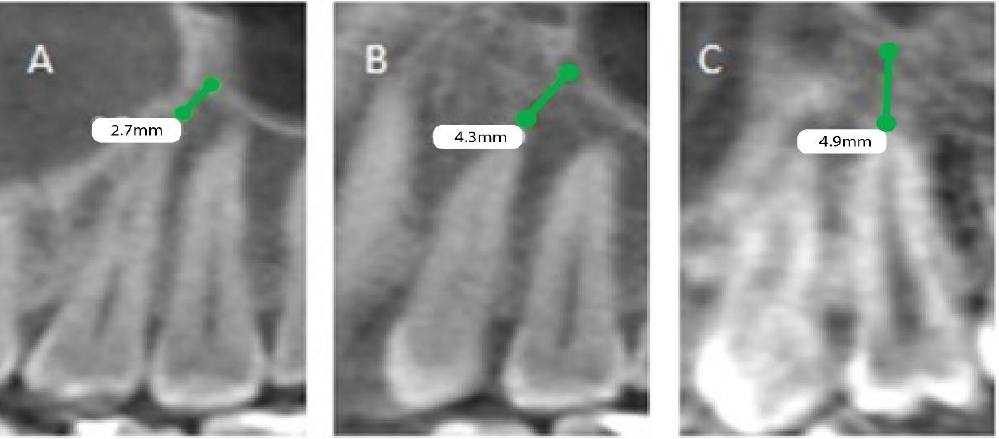
Figure 2. CBCT sagittal view showing the distance between the maxillary sinus and the root of permanent maxillary (left). ( A ) First premolar buccal root, ( B ) first premolar palatal root, ( C ) second premolar root.